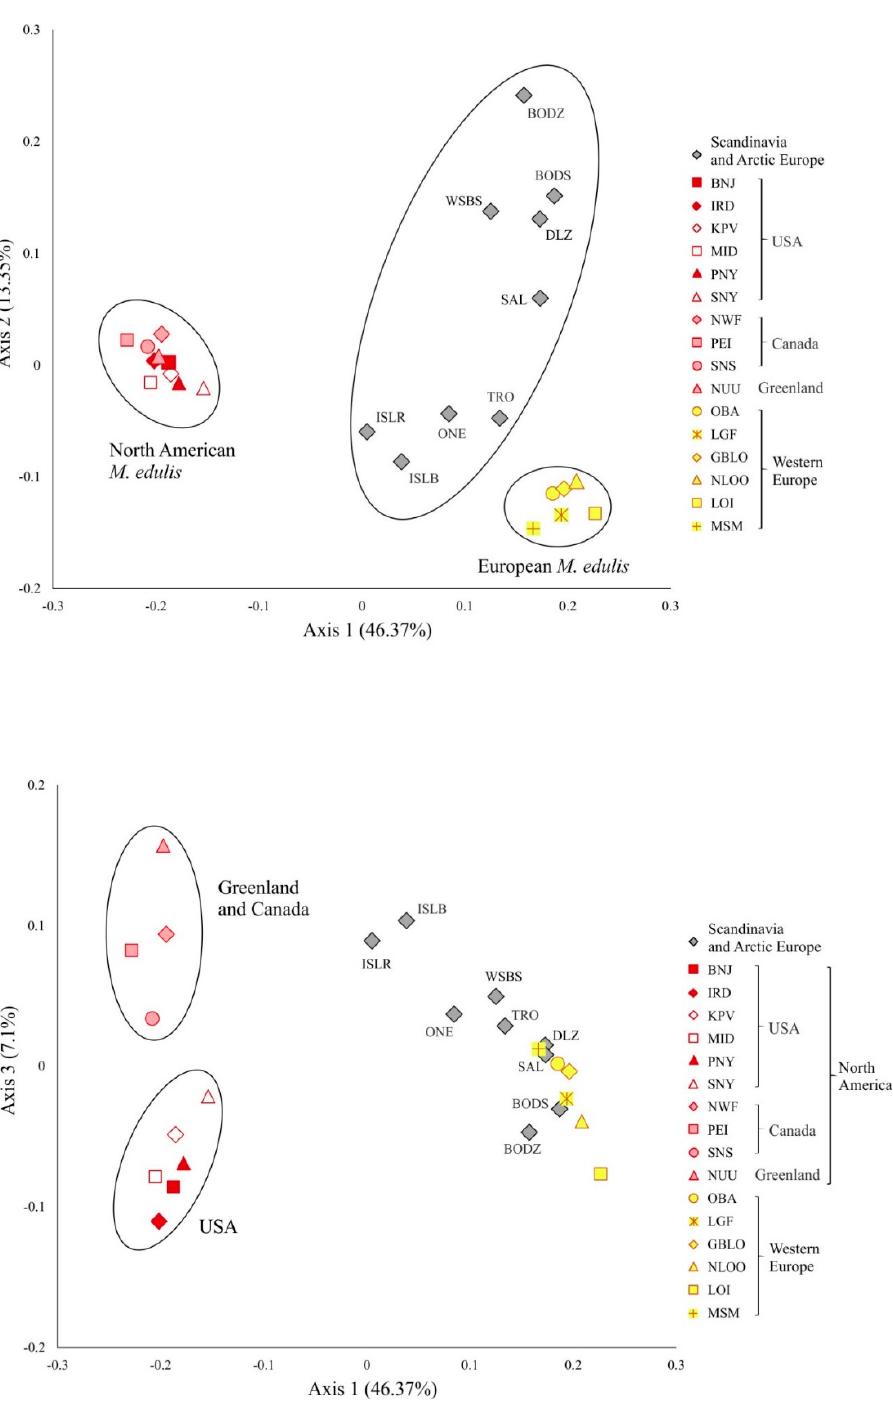
Figure 3. The first three axes of the correspondence analysis (CA) computed from the single nucleotide polymorphism (SNP) data on M. edulis from North Atlantic. Each point depicts a